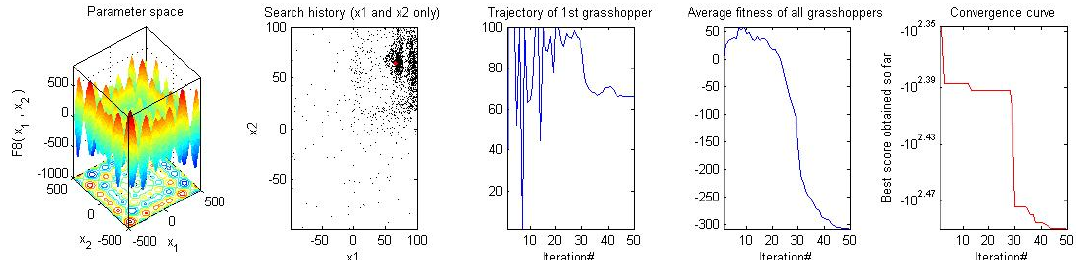
Figure 9. HAGOA search behavior on unimodal function